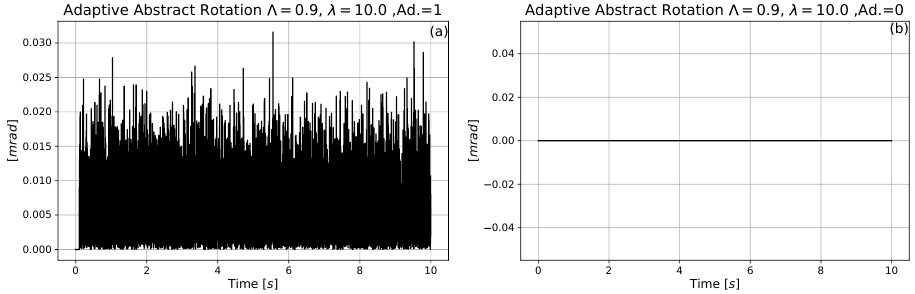
Figure 24. The control force. ( a ): Adaptive. ( b ):